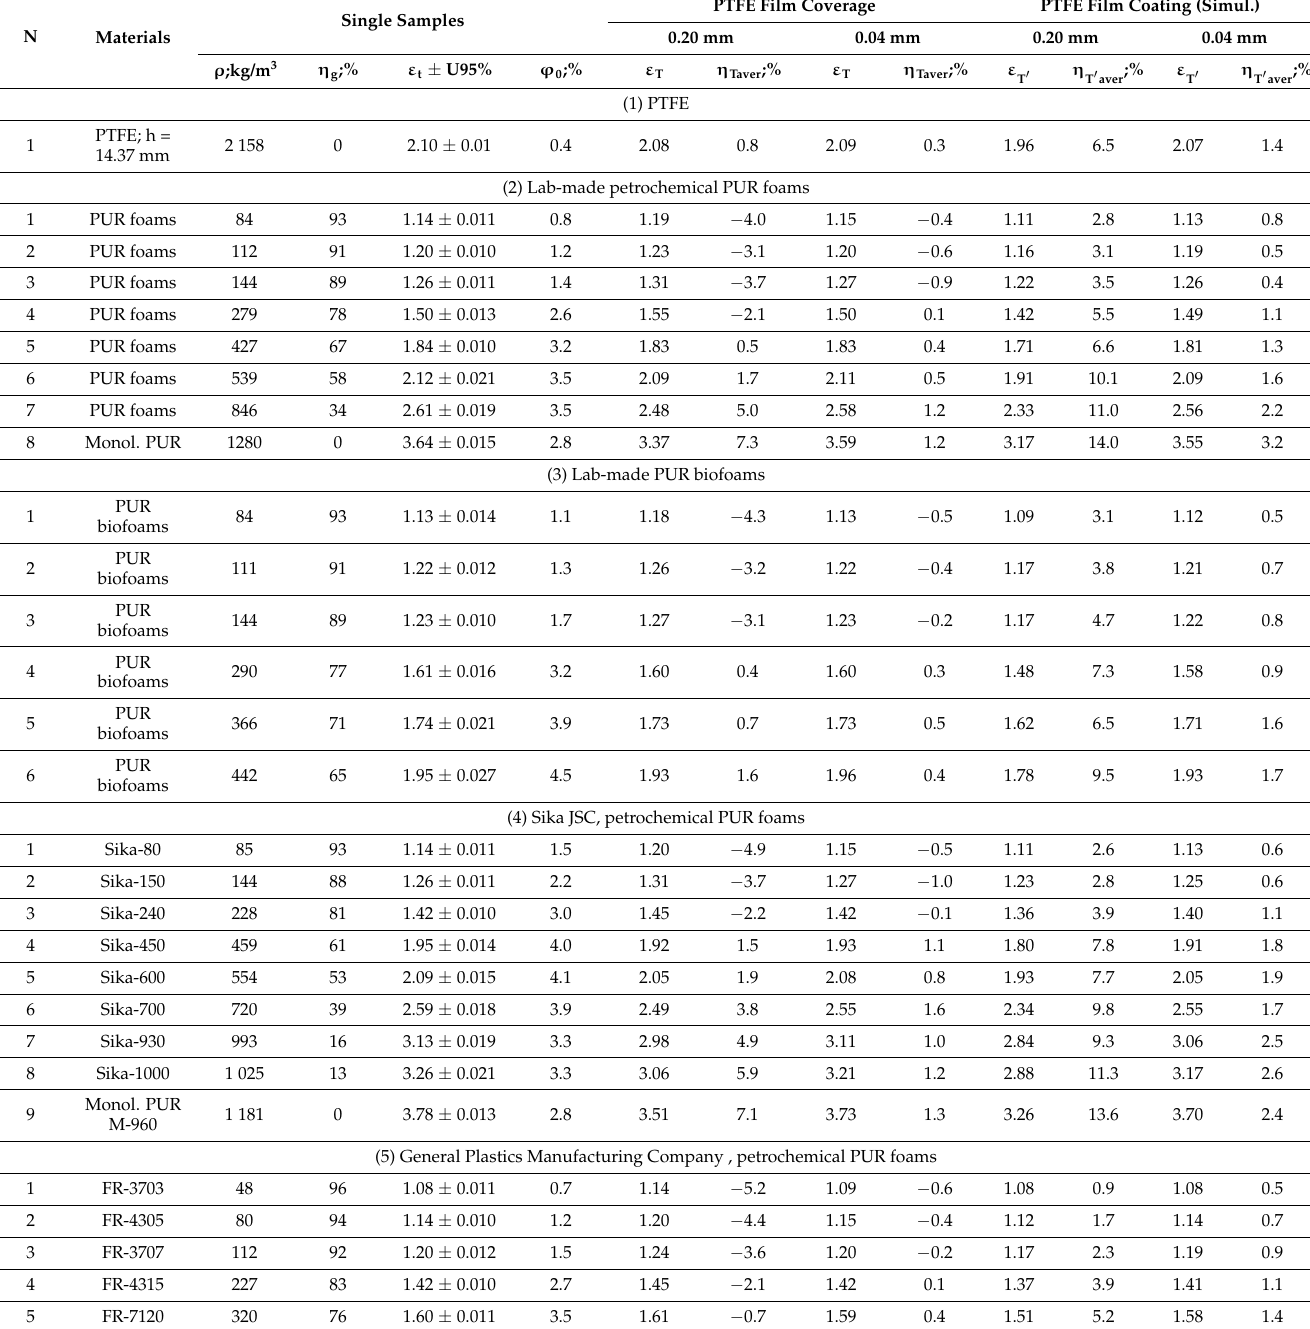
Table 1. Data of the permittivity spectra ε t , ε T and ε T (cid:48)